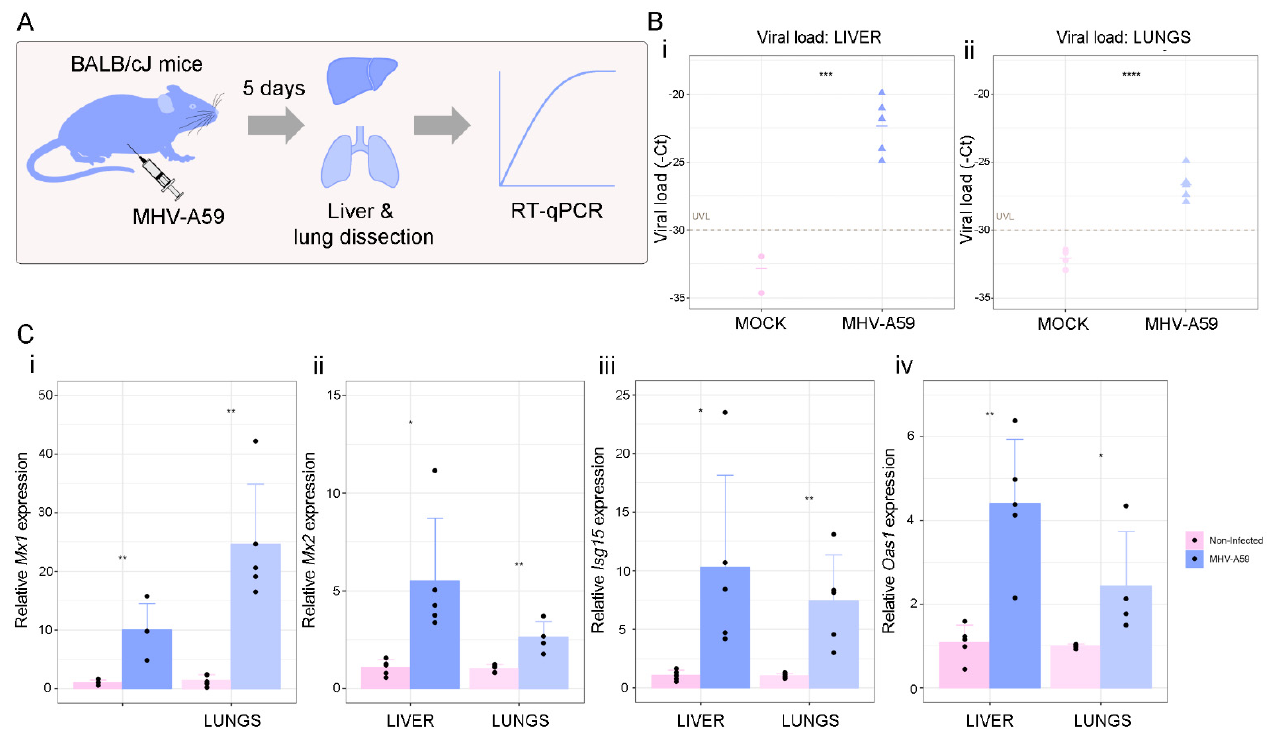
Figure 6. Analysis of ISGs expression in a pre-clinical model of Coronavirus infection. ( A ) Schematic representation of the experimental design. BALB/cJ female mice (n = 10) were used for the in vivo experiments. Mice were randomly distributed into two experimental groups: non-infected (n = 5) and infected (n = 5) groups. Mice were infected with 6000 PFU of MHV-A59 by intraperitoneal injection of 100 µ L of the virus diluted in sterile PBS. Five days after infection, mice were weighed and euthanized by cervical dislocation to dissect the liver and lung for RT-qPCR analyses. ( B ) Viral load was assessed by RT-qPCR in livers (i) and lungs (ii) of BALB/cJ mice infected (purple) or not (pink) with MHV-A59. Viral load is expressed as-cycle threshold (-Ct) by RT-qPCR for MHV. UVL: undetectable viral load. ( C ) Mx1 (i), Mx2 (ii), Isg15 (iii), and Oas1 (iv) expressions assessed by RT-qPCR in livers and lungs of BALB/cJ mice infected (purple) or not (pink) with MHV-A59. Values were relativized using Gapdh as a reference gene and normalized to the control. Student’s t -test was performed to determine statistical differences. Statistical significance * p < 0.05; ** p < 0.01; *** p < 0.001; **** p <